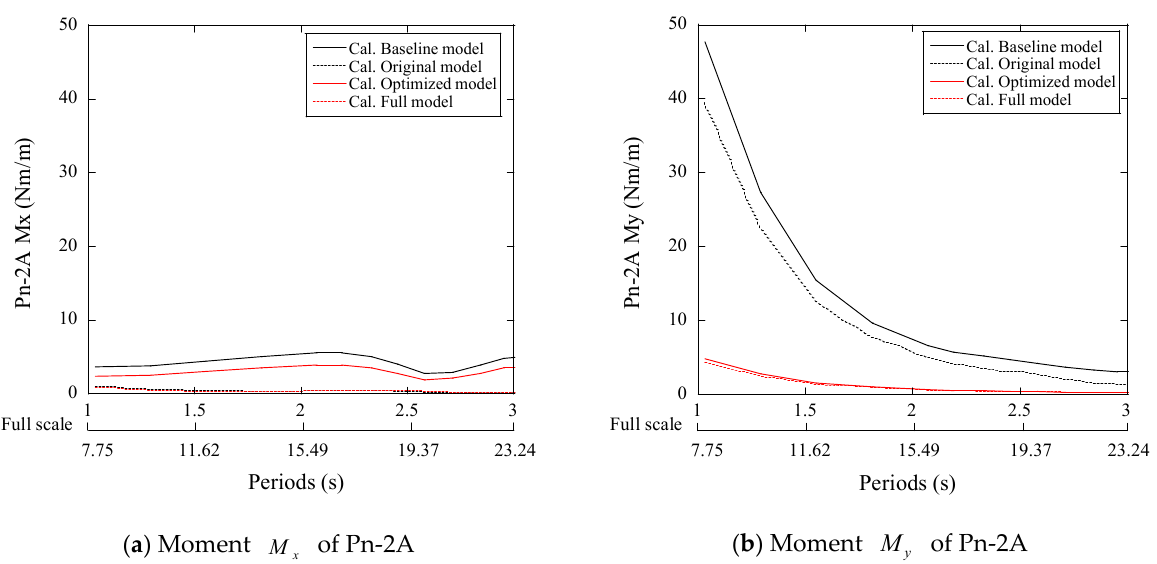
Figure 15. RAOs of bending moments around x and y axes at the section Pn-2A in the regular waves ( H = 0.15 m).